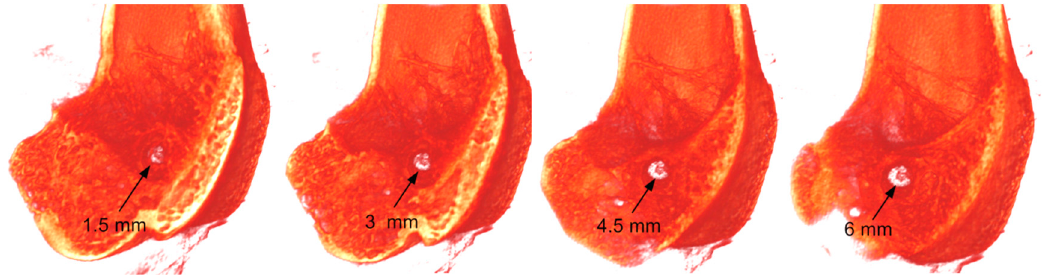
Figure 12. Slices of three-dimensional microCT images metaepiphysis femur with a transverse bore through 1.5, 3, 4.5, and 6 mm from the start of channel.